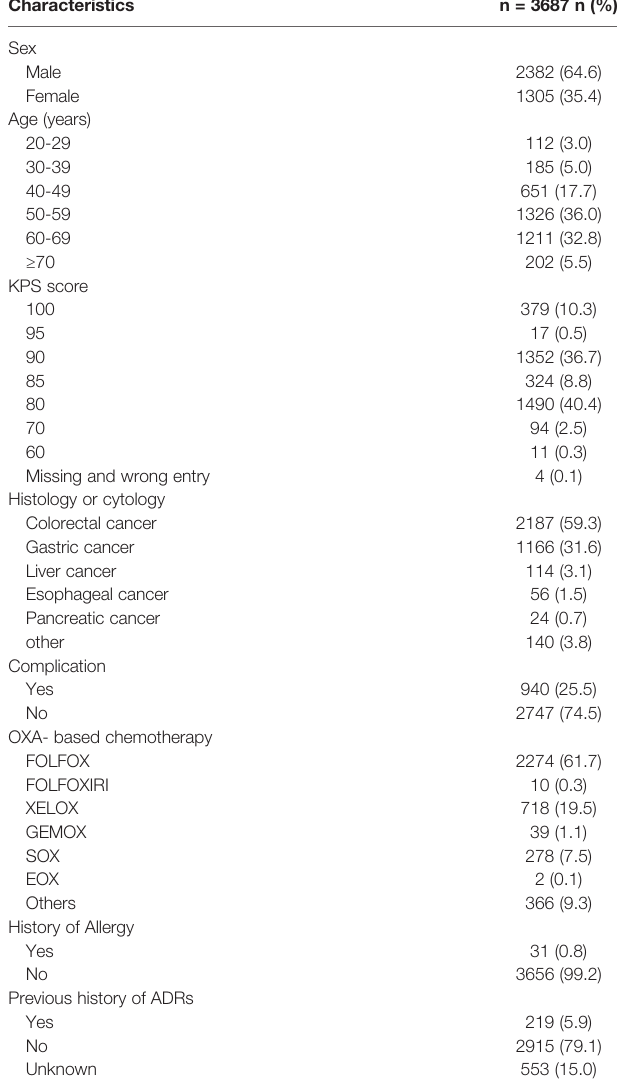
TABLE 1 | Patient demographics and baseline characteristics.